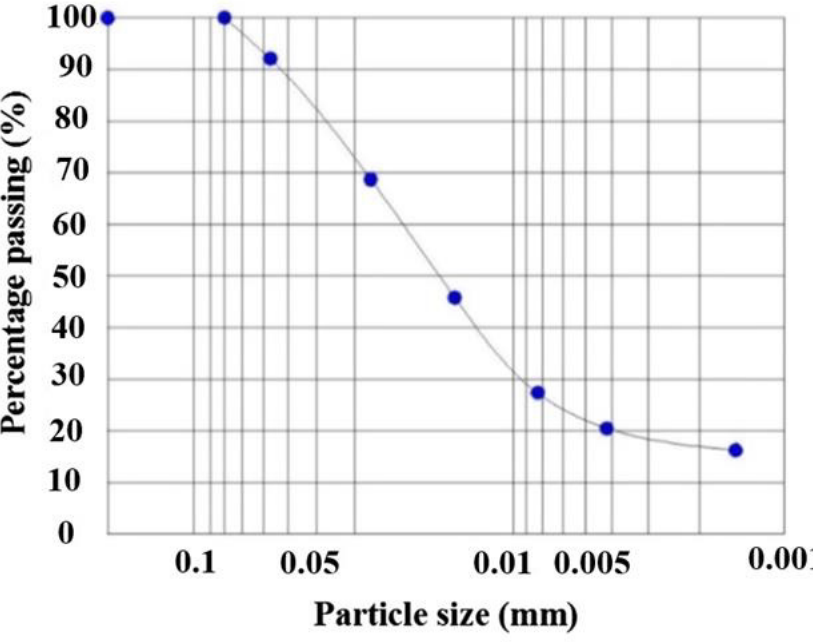
Figure 2. Particle size distribution curves.